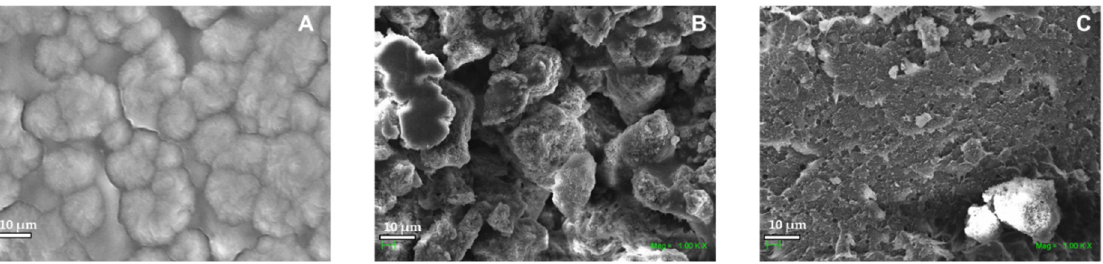
Figure 9. Electron micrographs of ( A ) neat PLA, ( B ) PLA/n-BGs 5 wt.%, and ( C ) PLA/n-BGs 10 wt.% at 1000×.